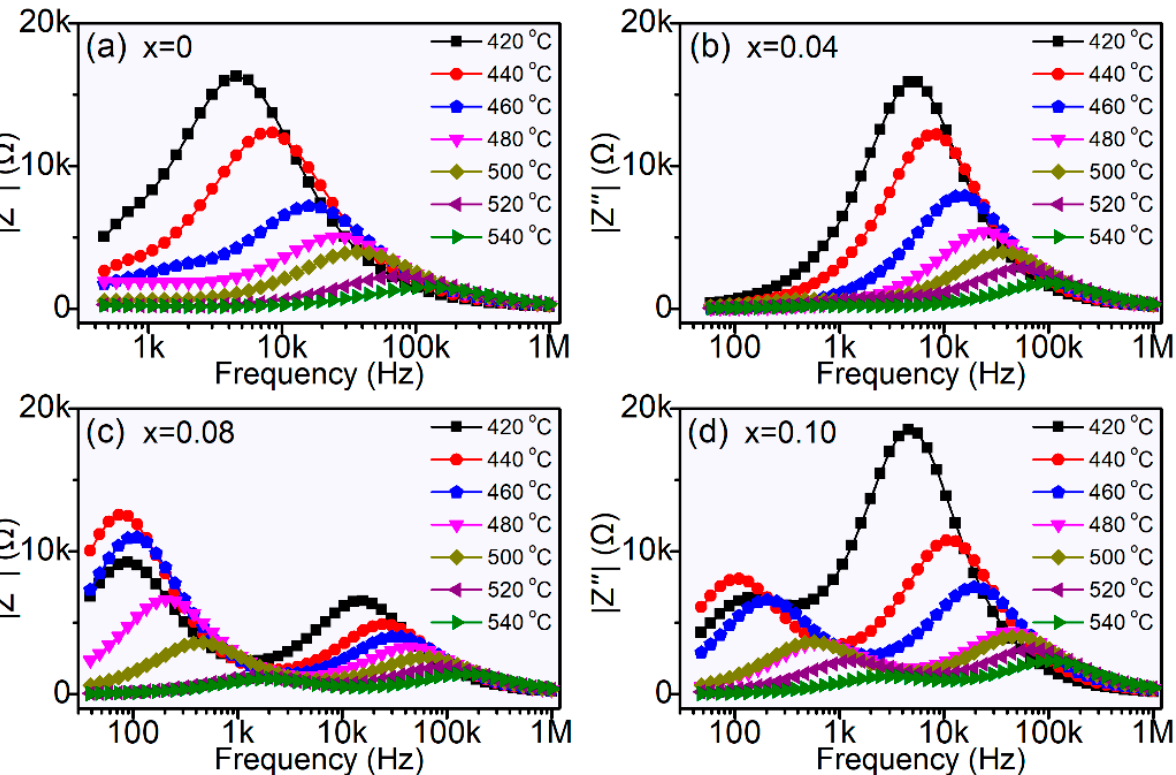
Figure 8. Frequency/temperature-dependent imaginary parts of impedances for KNNS x -BNN ceramics with ( a ) x = 0, ( b ) x = 0.04, ( c ) x = 0.08 and ( d ) x = 0.10 measured at high temperature.